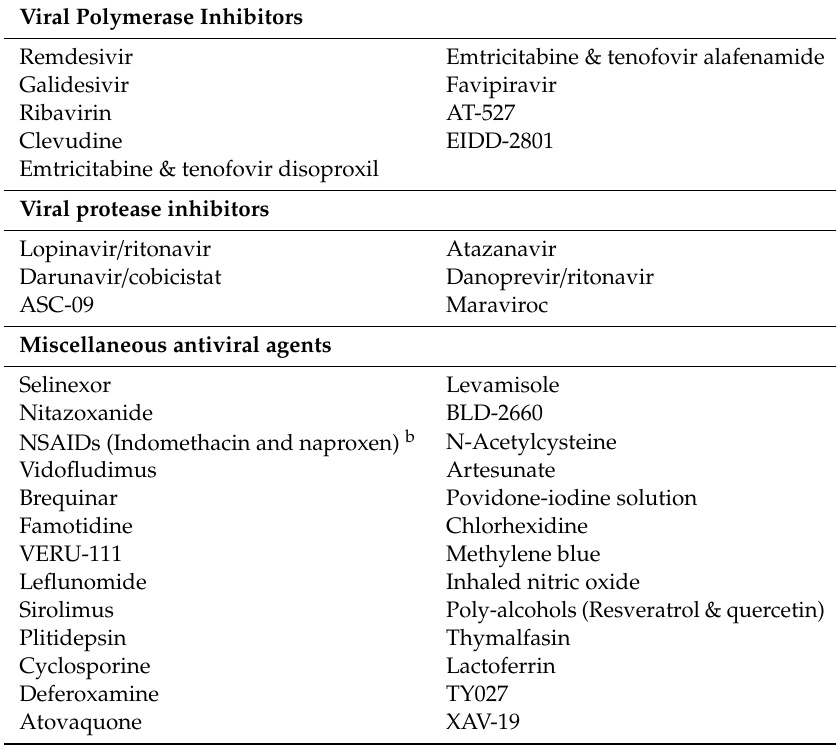
Table 1. Potential anti-COVID-19 therapeutics that are being tested in clinical trials based on targeting the post-entry events of the life cycle of SARS-CoV-2 a